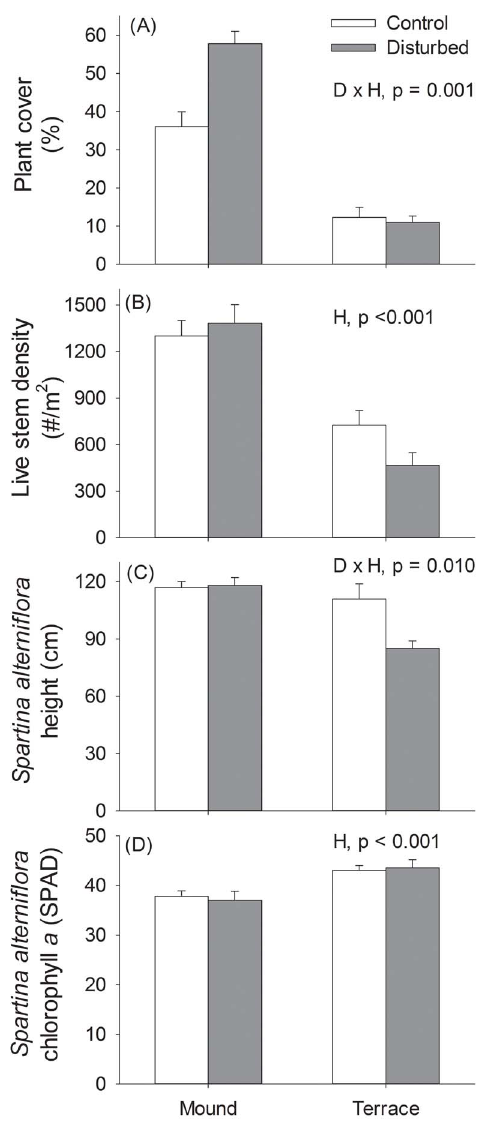
Figure 2. Disturbance and patch size effects on plant characteristics. Effects of disturbance treatments in large (terraces) and small (mounds) patches on plant characteristics: a) total plant cover, b) total live stem density, c) Spartina alterniflora stem height, d) relative Spartina alterniflora chlorophyll a content. Error bars represent standard error. Significant treatment effects from two-way ANOVA are noted; D=Disturbance, H=Habitat patch size.